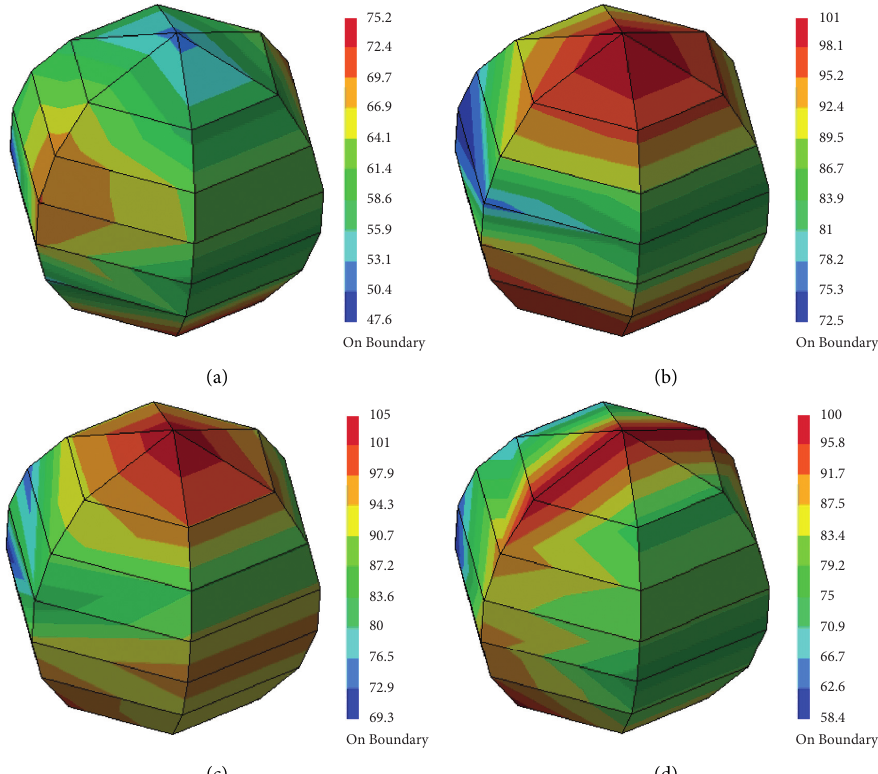
Figure 7: Acoustic radiation field at different frequencies based on ISO standard. (a) 50Hz. (b) 1000Hz. (c) 2000Hz. (d) 2950Hz.